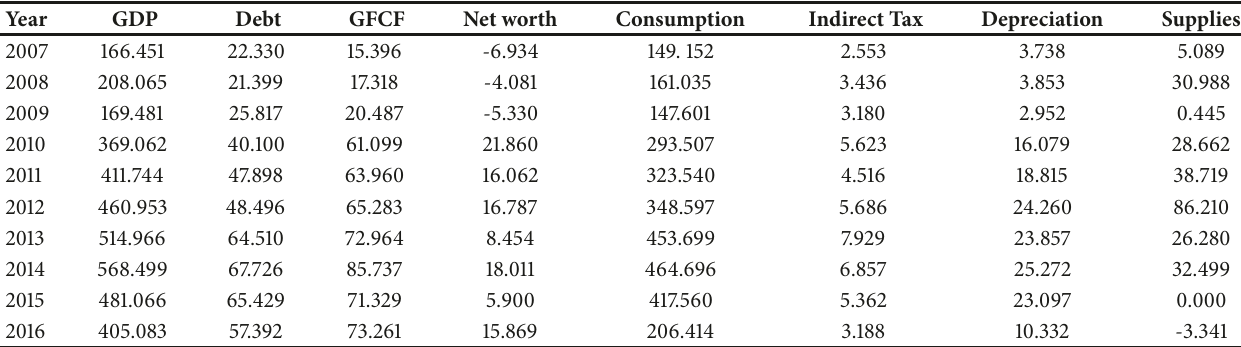
Table 3: Nigeria net worth profile.